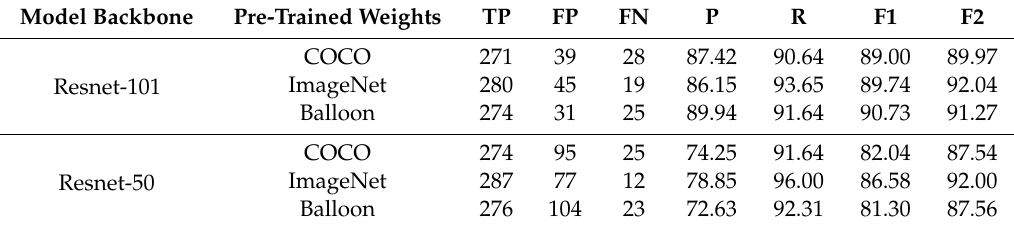
Table 2. Results from testing on CVC-ColonDB polyp data. COCO: Common Objects in Context, TP: